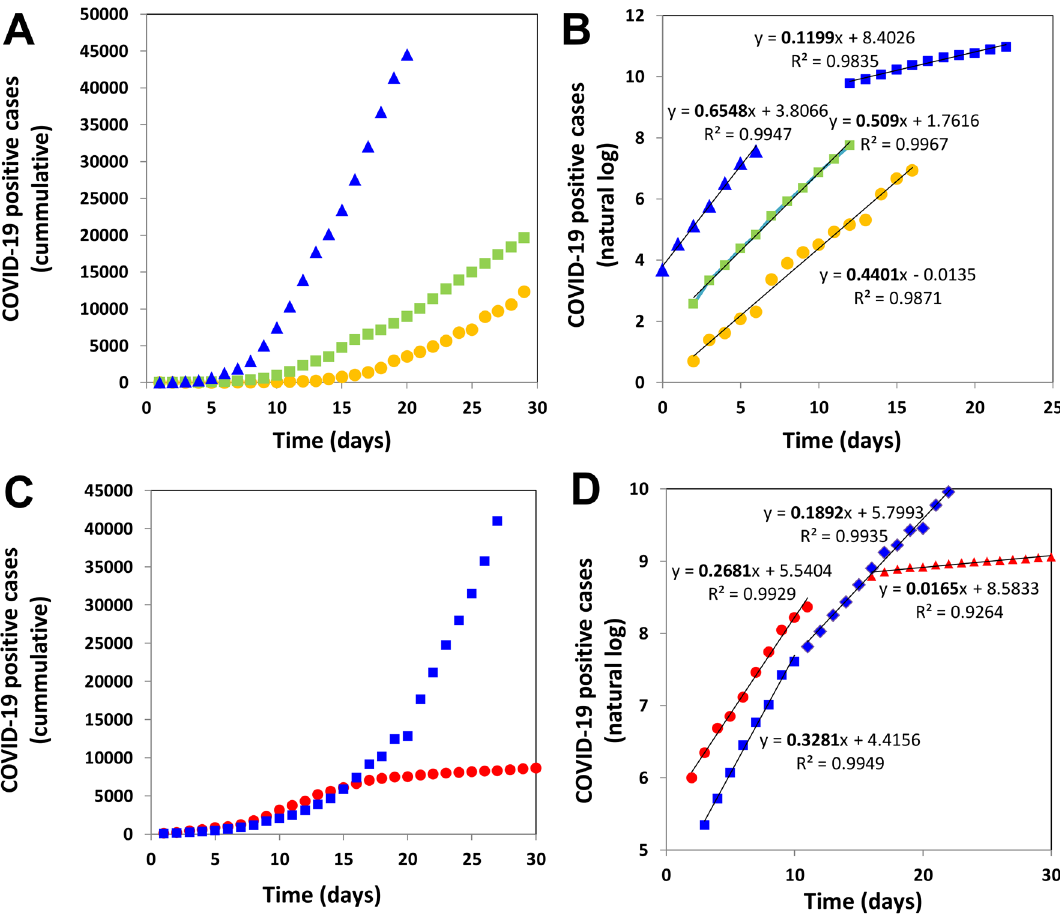
Figure 2. Epidemiological data related to the onset of a COVID-19 pandemic in different regions. ( A ) Cumulative number of positive cases of COVID-19 infection in Spain (yellow circles), Iran (green squares), and NYC (blue triangles) during the first days after the outbreak. ( B ) Natural logarithm of the cumulative number of positive cases of COVID-19 infection in Spain (yellow circles), Iran (green squares), and NYC (blue triangles and squares). ( C ) Cumulative number of positive cases of COVID-19 infection in Italy (blue squares) and South Korea (red circles). ( D ) Natural logarithm of the cumulative number of positive cases of COVID-19 infection in Italy (blue squares and diamonds) and South Korea (red circles and triangles). Two clearly distinctive exponential stages are observed in the case of the NYC and South Korean progression.